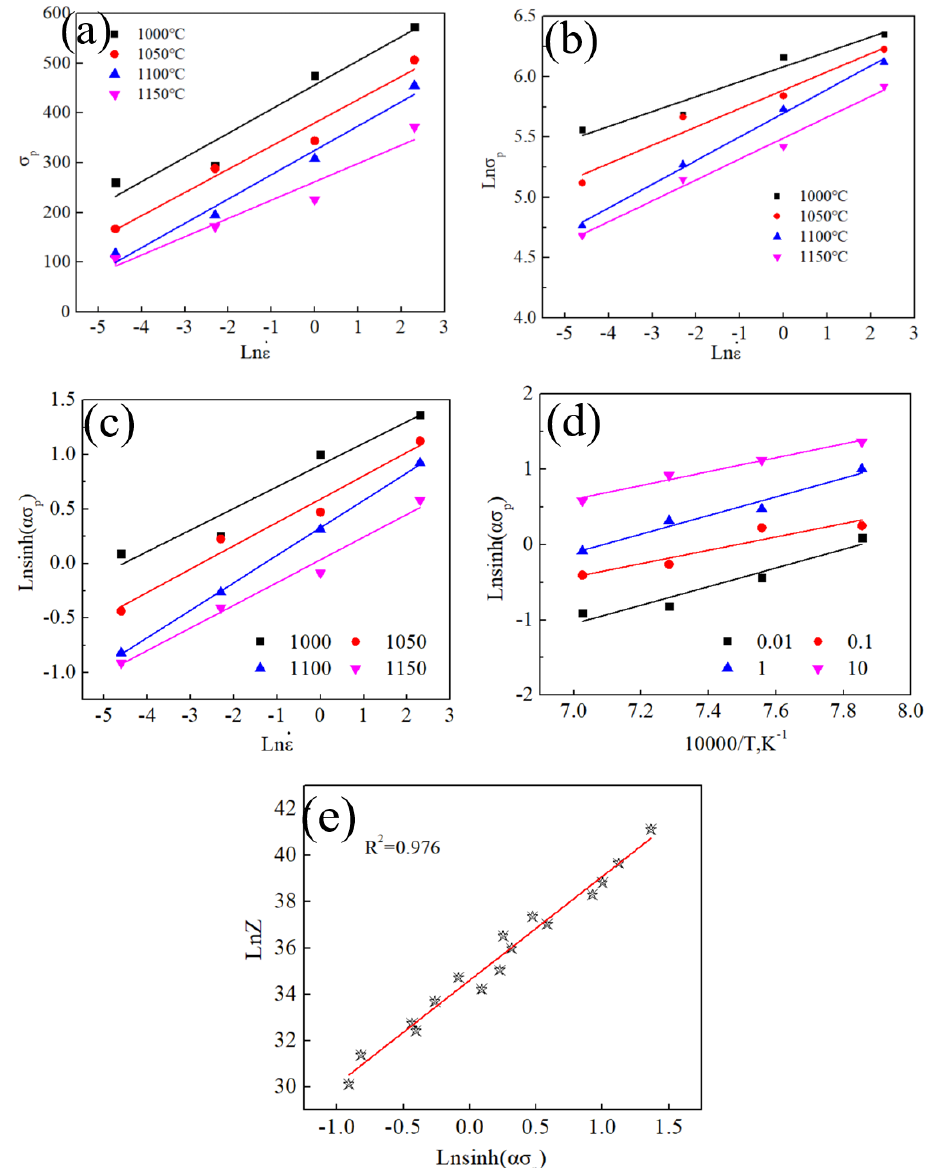
. . ε vs. σ p ; ( b ) ln ε vs. ln σ p ; ( c ) ln[sinh( α σ p )] vs. ln